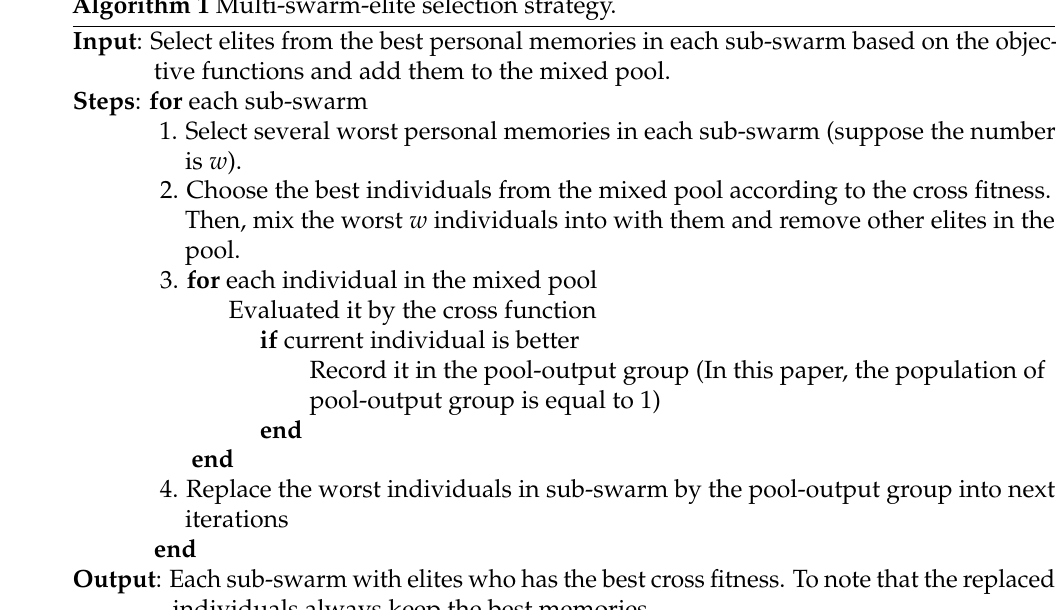
Algorithm 1 Multi-swarm-elite selection